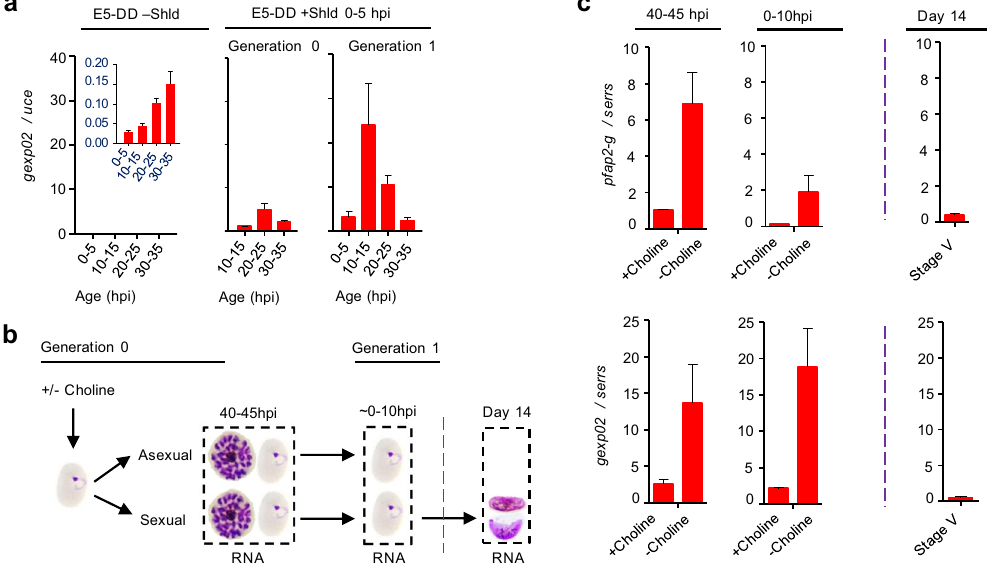
Figure 5. Transcriptional dynamics of the gexp02 gene. ( a) Transcriptional analysis of gexp02 in the E5-HA-DD line, in which PfAP2-G is fused to the FKBP destabilization domain, cultured either without Shield 1 (Shld) (no gametocytes are formed) or with Shld added at 0–5 hpi to stabilize PfAP2-G. The inset graph in the –Shld panel shows the same data with a different y-axis range, because under these conditions gexp02 transcripts levels were very low. Transcript levels are normalized against ubiquitin-conjugating enzyme (uce ) (PF3D7_0812600). (b) Schematic overview of the design of experiments aimed at comparing the transcriptional dynamics of pfap2-g and gexp02 in induced (choline-depleted) and uninduced (choline-supplemented) NF54-gexp02-Tom cultures. Analysis was performed at the schizont stage of the generation of induction (40–45 hpi, some new